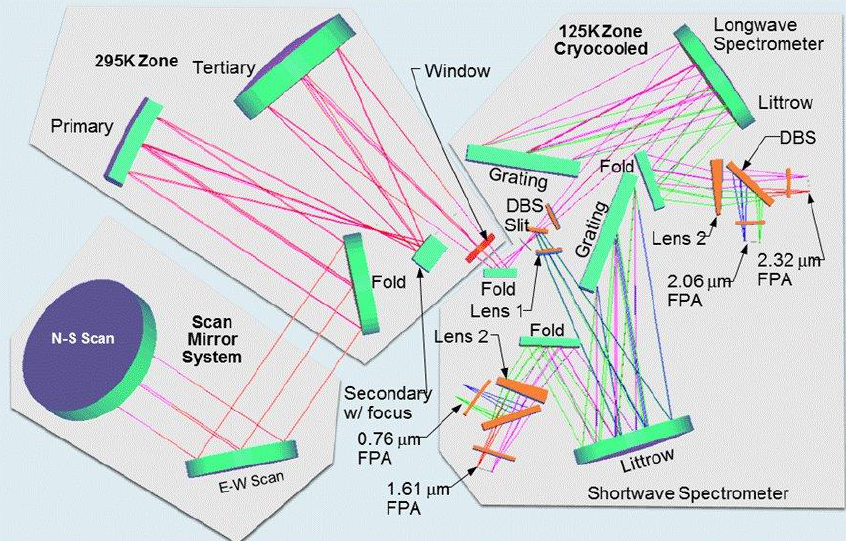
Figure 1. Optical layout for geoCARB. The primary beam splitter divides the long- and short-wave spectrometer arms. Each Littrow spec- trometer feeds two separate focal plane